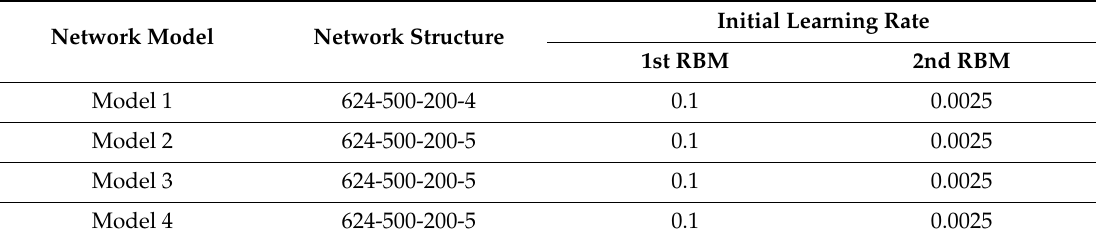
Table 3. Selection of parameters for hierarchical fault diagnosis